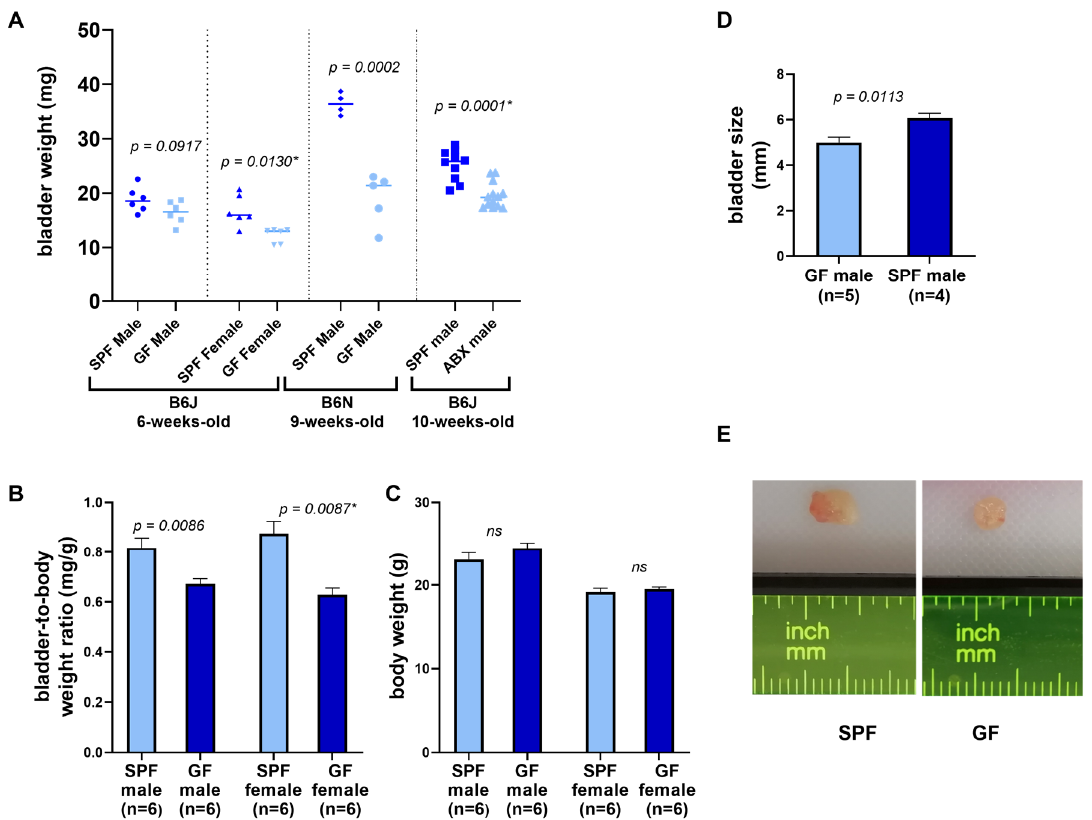
Figure 1. Comparison of bladder weight and size in germ-free and SPF animals. ( A ) Bladder weight of all groups of mice. ( B ) Bladder-to-body weight ratio of B6J 6-weeks-old mice shown in mg / g units. ( C ) Body weight of B6J 6-week-old mice. ( D ) Bladder size (length in mm) of B6N 9-week-old mice. Bars represent mean ± SEM. Student T-test ( p -value without asterisk) and Mann-Whitney test were used to determine significance ( p -value with asterisk). ( E ) Representative photographs of GF and SPF bladders. (ABX—antibiotics, ns—non-significant).